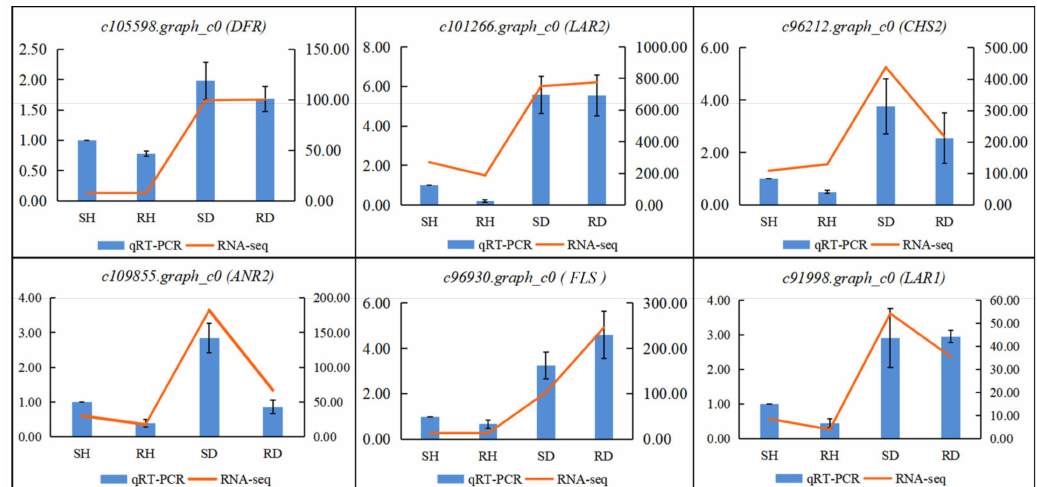
Figure 8. The relative expression levels of six selected DEGs were compared by RNA-seq and qRT- PCR. The line chart shows the gene expression level from the transcriptome (FPKM); The qRT-PCR expression levels were calculated as a ratio relative to the level of expression of uninfected susceptible line CL102 (SH), which was set as